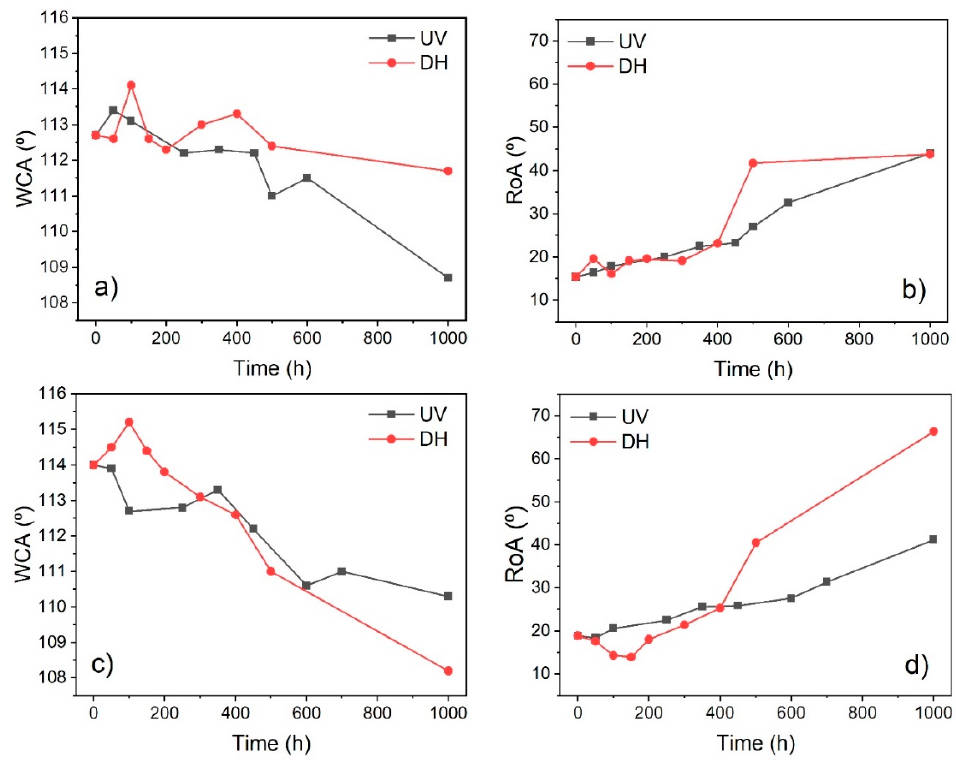
Figure 8. ( a ) WCA and ( b ) RoA measurements for up to 1000 h of UV and DH exposure of hydrophobic coatings prepared by spray-coating; ( c ) WCA and ( d ) RoA after UV and DH exposure of hydrophobic coatings prepared by dip-coating. Each data point is an average of 7 measurements at different points on the 5 cm × 5 cm coated coupon surface for WCA and an average of 5 measurements for